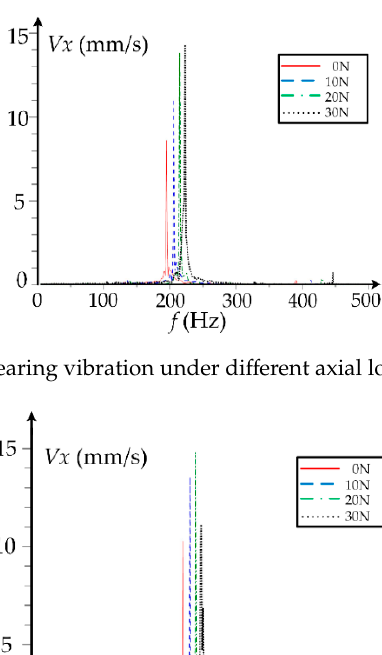
Figure 11. The bearing vibration under different axial loads when L = 1.1.